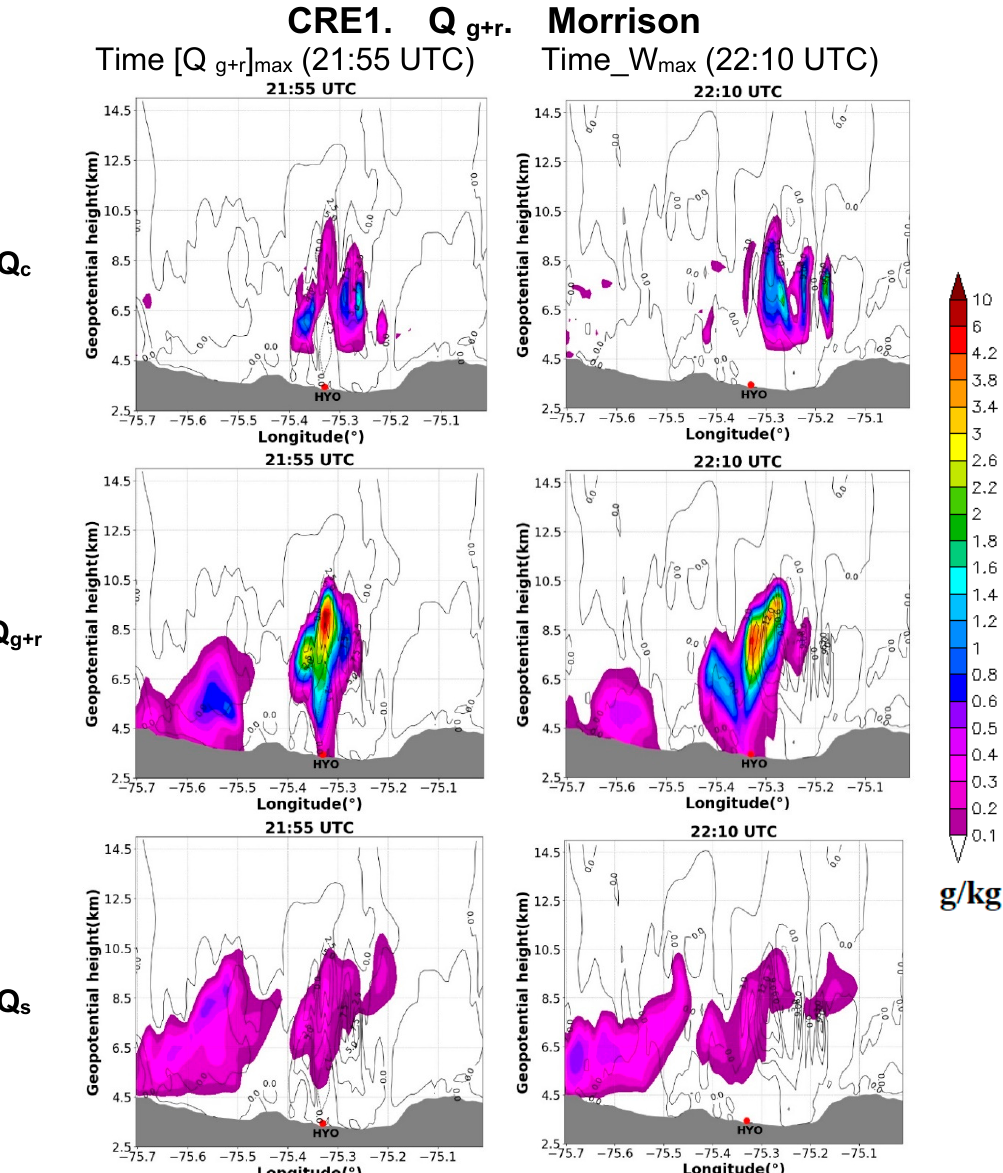
Figure 18. Vertical distribution of vertical wind velocity and mixing ratios of hydrometeors, Q c , Q g+r , and Q s , at two maximum development moments: the time of maximum mixing ratio of graupel + rain water, Q g+r (left), and the time of maximum vertical velocity, W (right). Latitudinal cross section at approximately 12° S latitude, crossing HYO between 5.65 and 75.2° W. WRF output for CRE1 using the Morrison scheme.